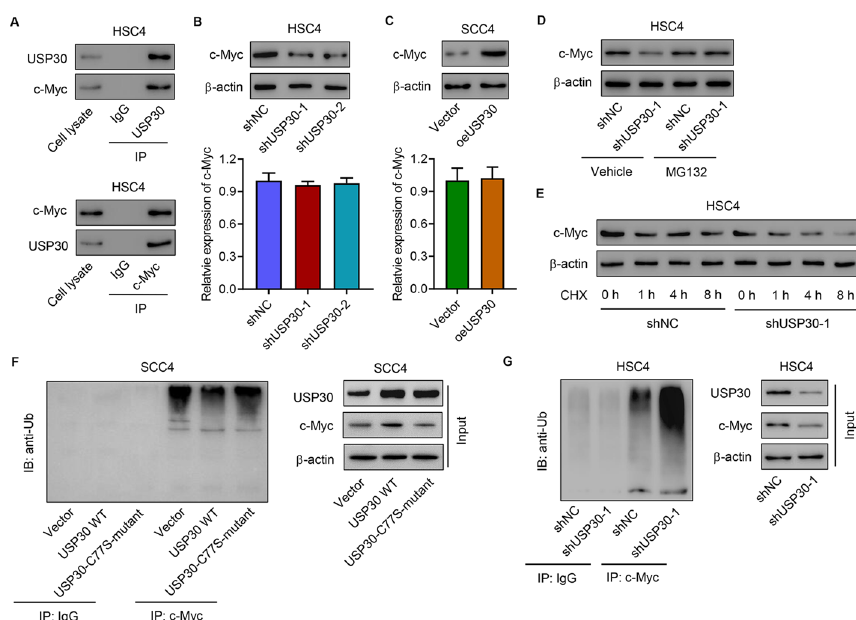
Fig. 3 USP30 promotes c-Myc deubiquitination. A Interaction between USP30 and c-Myc in HSC4 cells. c-Myc expression in B HSC4 and C SCC4 cells with or without USP30 knockdown and overexpression. c-Myc levels in HSC4 cells with USP30 knockdown with or without D protease inhibitor MG132 (10 μM) or E CHX treatment. F Effect of USP30 overexpression on c-Myc ubiquitination in SCC4 cells transfected with WT-USP30, C77S-mutant USP30, or vector. G Effect of USP30 knockdown on c-Myc ubiquitination in HSC4